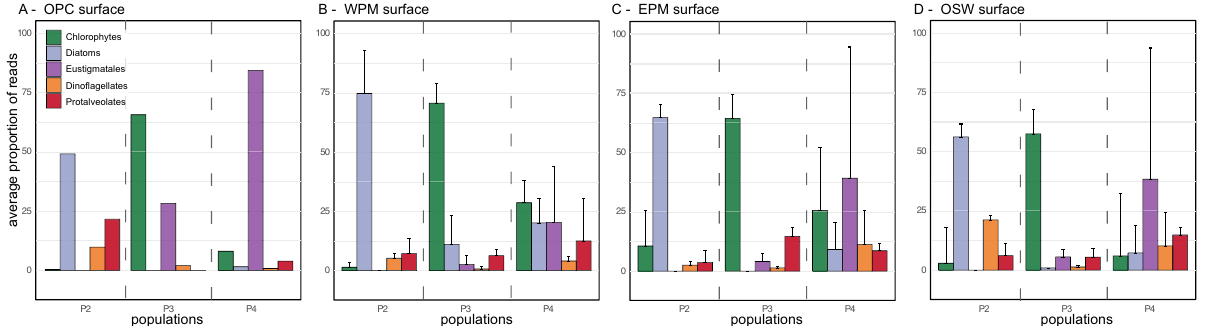
Figure 4. Barplot of the five most abundant taxa, per population for each habitat type in surface samples. OPC, old plume core; WPM, west plume margin, EPM, east plume margin; OSW, ocean seawater. Error bars indicate one-sided standard deviation among samples of the same habitat type. Absence of error bars when there was only one sample per habitat